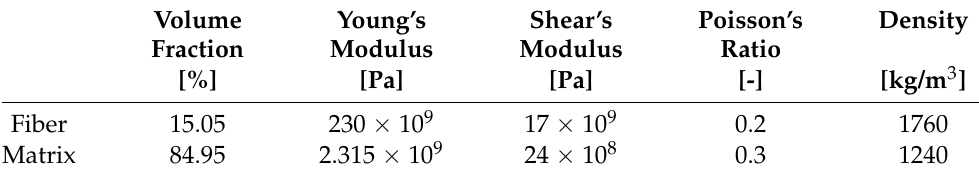
Table 1. Material Properties of the fiber and matrix.